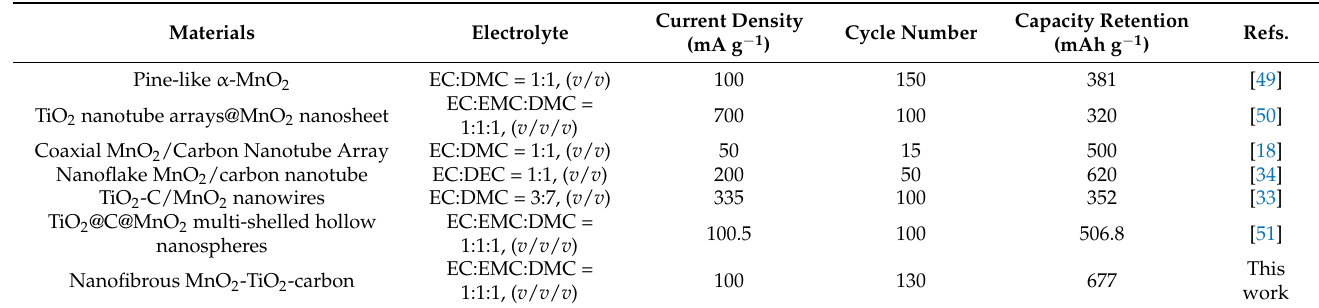
Table 2. Comparisons of the contributed capacities and percentages of MnO 2 to the theoretical capacities in the MnO 2 -TiO 2 -carbon-47.28%, 37.81%, (sample-47.28%, -37.81%), and MnO 2 -carbon-40.15%, 33.30% (sample-40.15%, -33.30%), TiO 2 -carbon and MnO 2 -NPs electrodes.